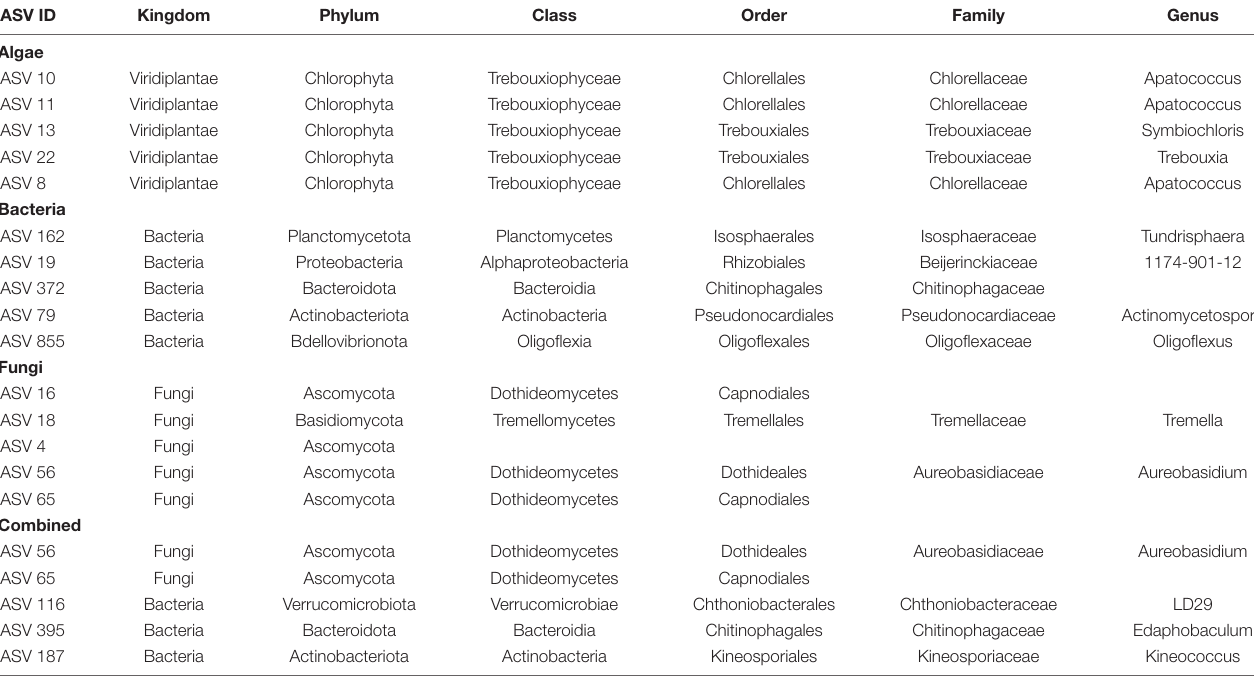
TABLE 4 | Taxonomic information for the hub taxa of the respective network, identified based on their betweenness